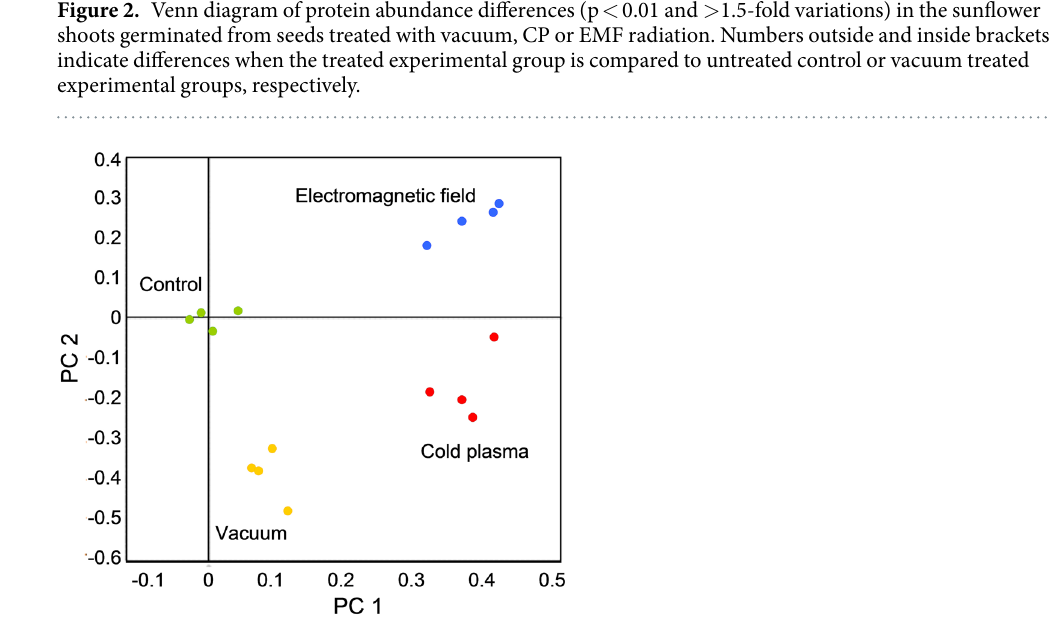
Figure 3. Principal component analysis of the differentially expressed protein data in sunflower shoots germinated from the seeds treated with vacuum and/or CP and EMF. Spots of the same color represent four biological